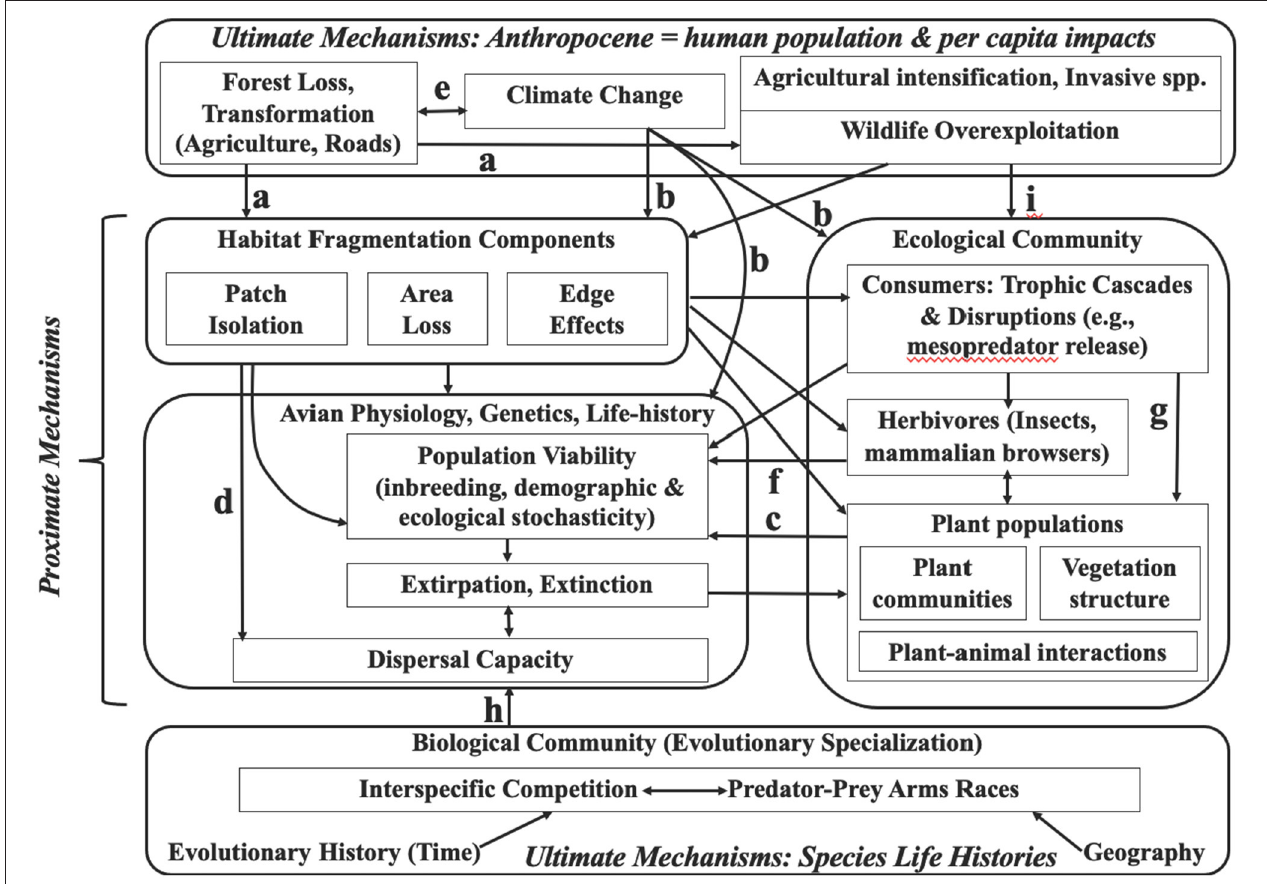
FIGURE 1 | Diverse mechanisms (arrows) of Anthropocene global change impacts, emphasizing insectivorous birds. A variety of mechanisms (lettered) are particularly important in the tropics—see text for further explanation and references. (a) Increased forest loss and road construction dramatically increase forest accessibility to subsistence hunting and habitat degradation via a variety of mechanisms including forest fragmentation, fires, and further human exploitation of various resources. These are ultimate, mostly direct mechanisms. (b) Climate change alters avian geographic ranges, impacts that will be particularly dramatic in the tropics, given extensive elevation gradients and small geographic ranges, high species richness, and endemism (e.g., the Andes). These are ultimate, and mostly indirect impacts. (c) Indirect effects of structural and floristic vegetation change on birds due to modification of habitat and microhabitat, which in turn impacts feeding and nesting sites. Some of these are the indirect impact of trophic cascades. (d) An important ultimate mechanism highlighted in this paper involves many tropical birds poorly adapted for dispersal, making them highly vulnerable to forest patch isolation and indirectly to many demographic consequences of small population size. These are mostly indirect mechanisms. (e) Climate change interacts reciprocally with forest loss and fragmentation, which has largely ultimate, indirect impacts. (f) Bottom-up impacts of insect declines are both proximate and direct. (g) Top-down impacts of predator losses triggering trophic cascades, such as Meso-predator Release Hypothesis, indirectly reduce avian feeding and reproduction, a proximate threat. (h) The Biotic Challenge Hypothesis (BCH), explains evolutionary feeding specialization in the tropics and consequence of reduced dispersal due to tradeoff between feeding efficiency and dispersal capacity—an ultimate, indirect threat. (i) Multiple hypotheses stemming from pesticides, wildlife overexploitation, and invasive species impact insect abundances (mostly declines) and trophic chain disruptions, contributing ultimate threats that are both direct and indirect. Modified and extended from Robinson and Sherry (2012) and Sherry et al.